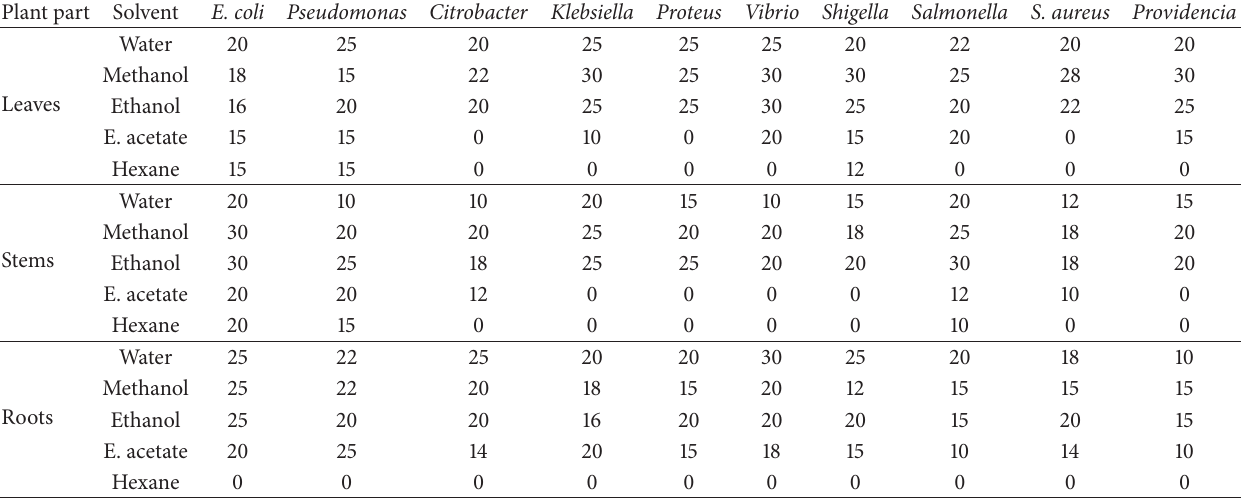
Table 4: Antibacterial activity of fifteen extracts of Adiantum capillus veneris against various MDR bacterial strains. Plant part Solvent E. coli Pseudomonas Citrobacter Klebsiella Proteus Vibrio Shigella Salmonella S. aureus Providencia